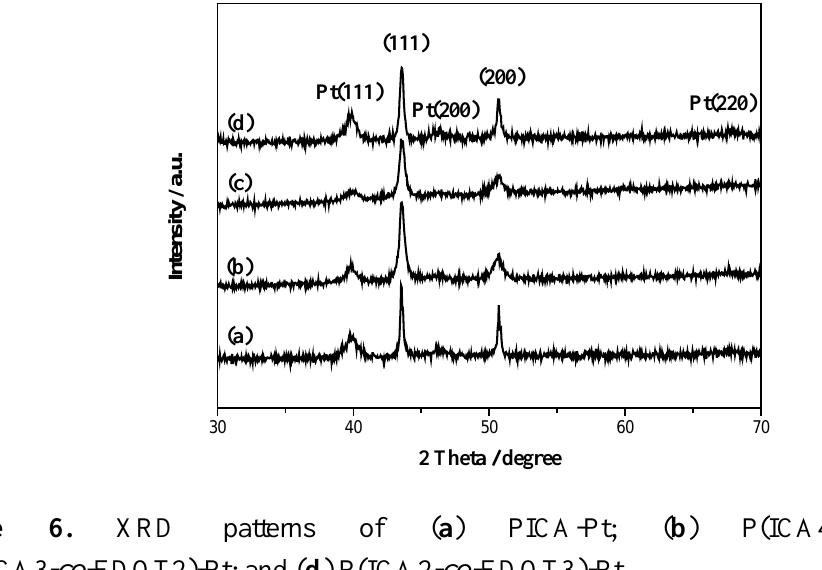
Figure 6. XRD patterns of ( a ) PICA-Pt; ( b ) P(ICA4- co -EDOT1)-Pt; ( c ) P(ICA3- co -EDOT2)-Pt; and ( d ) P(ICA2- co